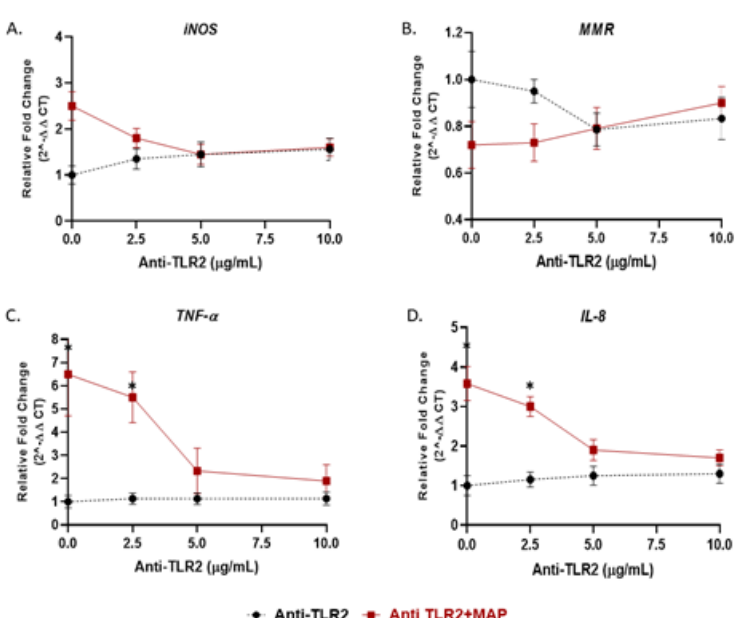
Figure 4. TLR2 antagonist decreases the macrophage response against MAP infection: M1, M2, TNF- α , and IL-8 studies. THP-1-PMA-differentiated macrophages were infected with MAP for 24 h after pretreatment with 0, 2.5, 5 and 10 µ g / mL of MMG11 (Anti-TLR2). Expression of iNOS ( A ), MMR ( B ), TNF- α ( C ) and IL-8 ( D ) were measured by RT-PCR. All experiments were performed in duplicates. * p < 0.05.